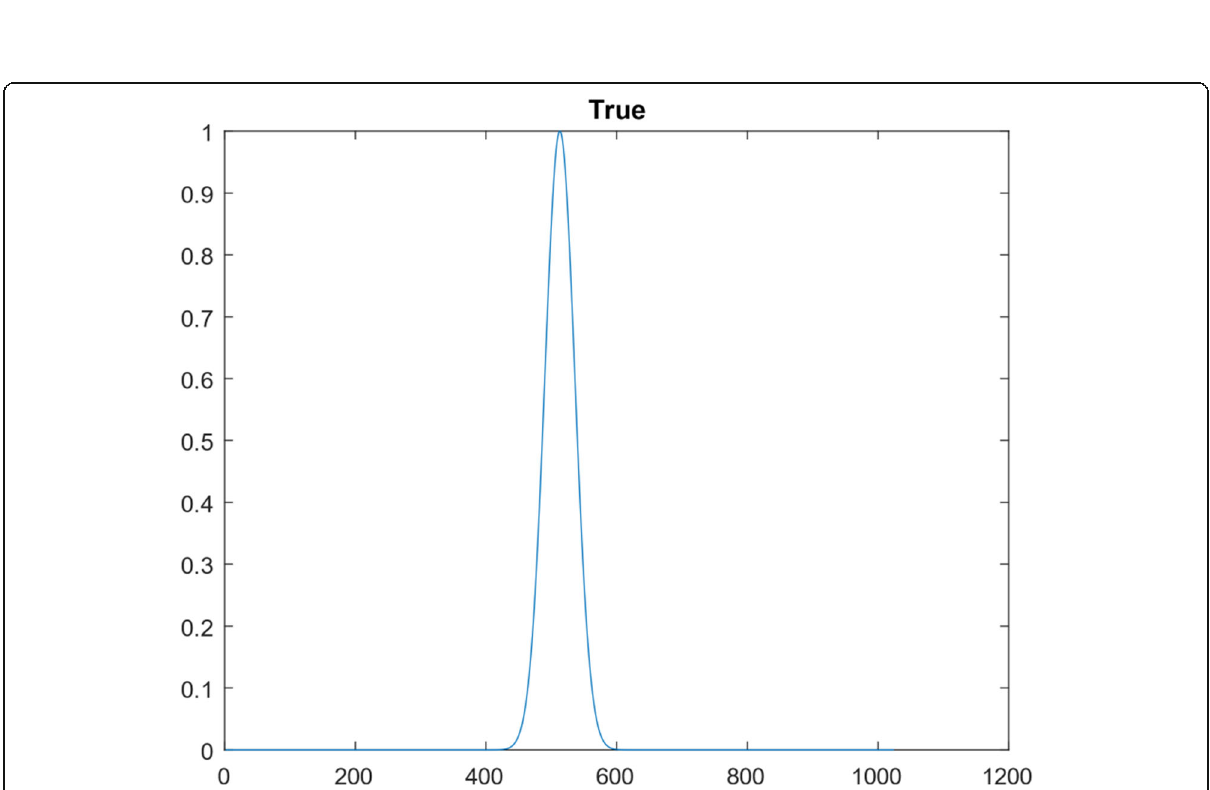
Fig. 10 The true Gaussian